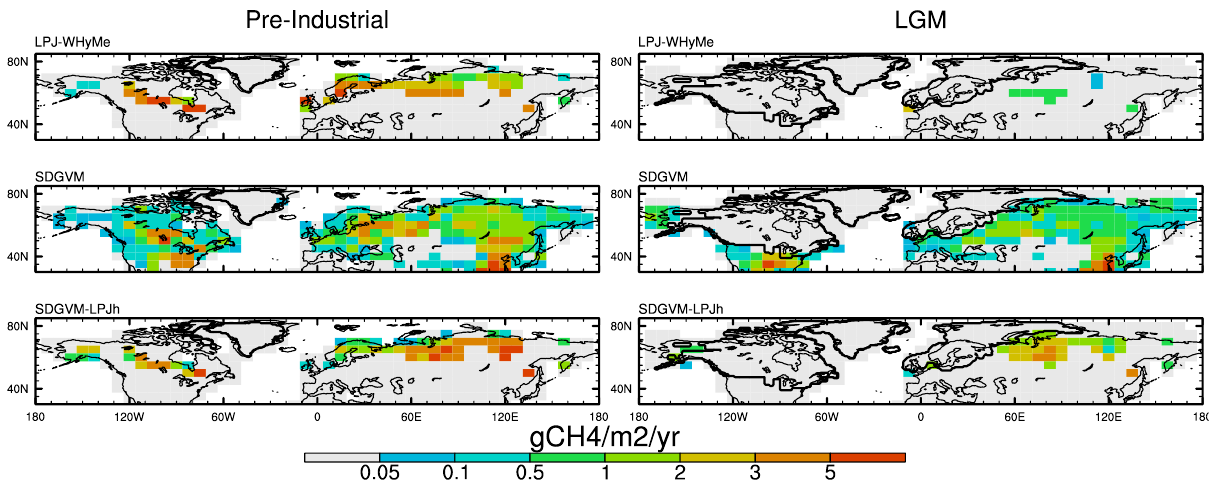
Fig. 5. CH 4 emissions for PI and LGM conditions for LPJ-WHyMe, SDGVM and SDGVM-LPJ-h, including a correction for the fractional land area in coastal grid cells. The distribution of land ice in each simulation is shown by the black contour line.